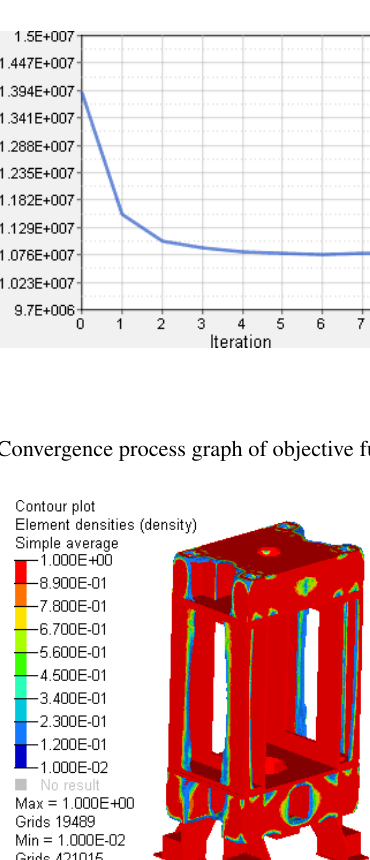
Figure 11. Topology optimization steps.